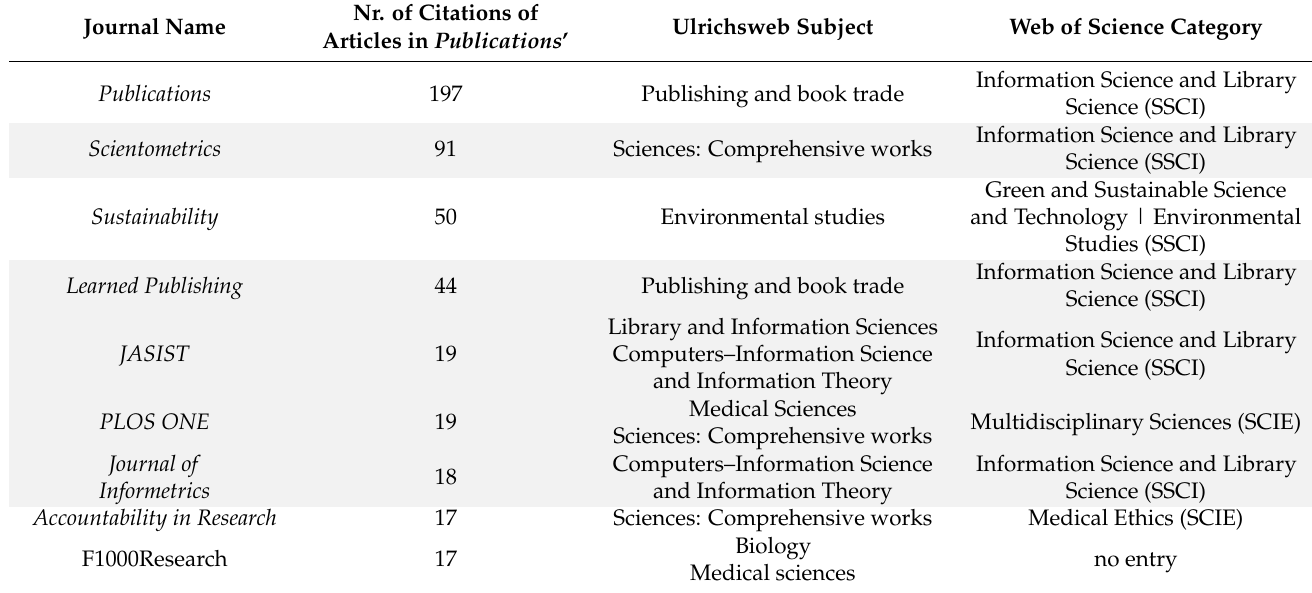
Table 8. Top journals that each have over 1% of all citations (n = 1687).